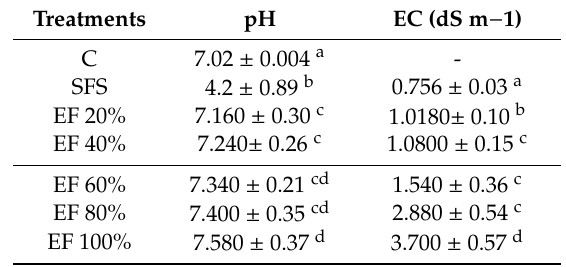
Table 2. Physico-chemical properties of LSEs, pH and EC (dS m − 1 ).